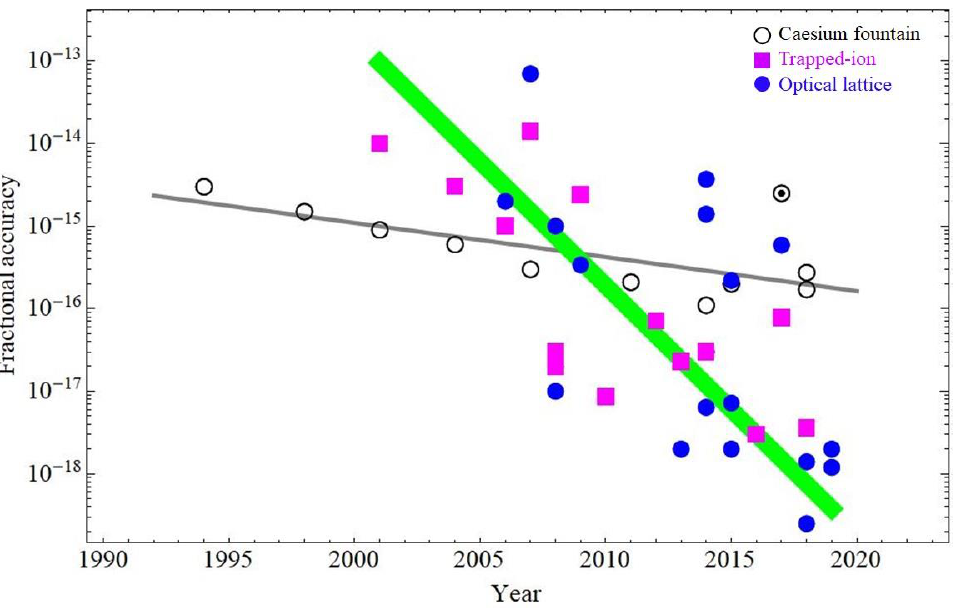
Figure 2. Worldwide status of optical clocks with their reported accuracies based on a single trapped ion (magenta) and neutral atoms in optical lattices (blue) over the last two decades. Accuracies of microwave caesium fountain clocks (black) are also depicted here for comparison. The reported accuracy of the only developed Indian caesium fountain at NPL, New Delhi (NPLI-CsF1) is indicated by the dot surrounded by a circle (black), and is about an order of magnitude lower in accuracy than the world’s best fountain clock [99]. The solid lines indicate the MW (grey) and optical (green) clocks’ data to indicate the improvement rates in their accuracy.